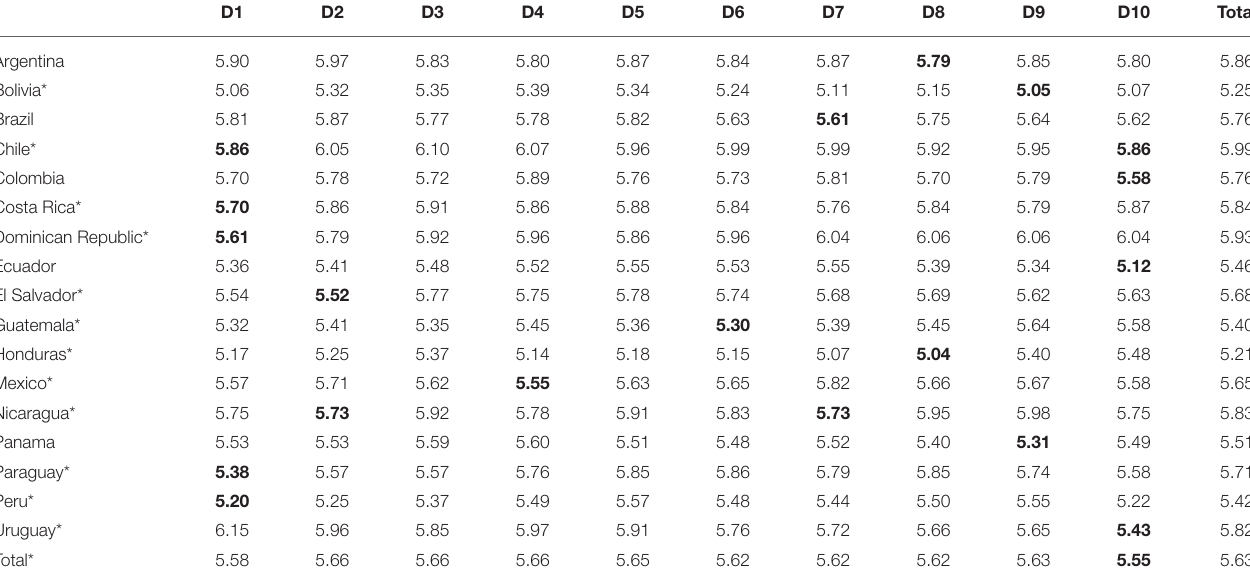
TABLE 2 | Average support for redistribution of income deciles, by